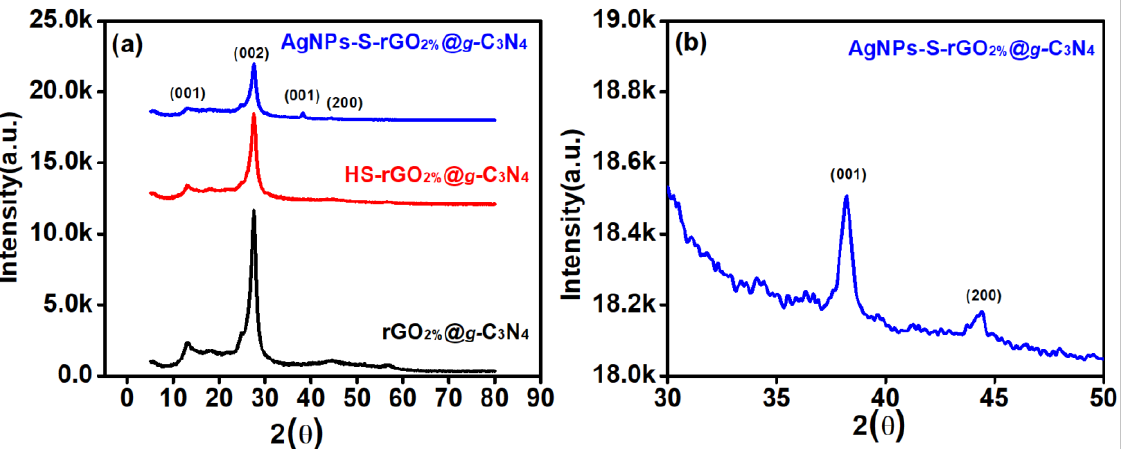
Figure 2. ( a ) Diffraction patterns of rGO 2% @ g -C 3 N 4 , HS-rGO 2% @ g -C 3 N 4 and AgNPs-S-rGO 2% @ g -C 3 N 4 whilst ( b ) enlarged spectra of AgNPs-S-rGO 2% @ g -C 3 N 4 taken between 30 to 50°.